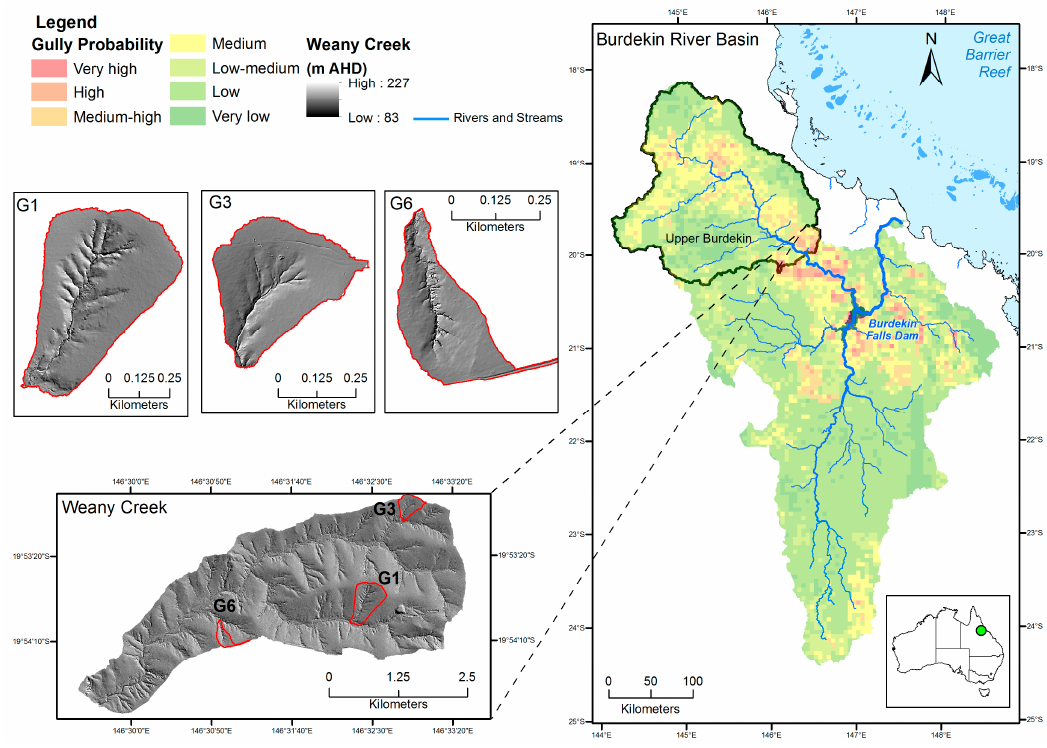
Figure 1. Map showing the location of the study sites within the Weany Creek sub-catchment, within the Upper Burdekin catchment and part of the Burdekin River Basin. The gully probability mapping is reproduced with permission from Gilad et al. [84] and shows high to very high probability of gullies in the Upper Burdekin catchment. The Weany Creek DEM and the Hillslope DEMs are derived from airborne LiDAR captured in 2013, outlined in Tindall et al. [76]. ISPRS Int. J. Geo-Inf. 2017 , 6 , 328